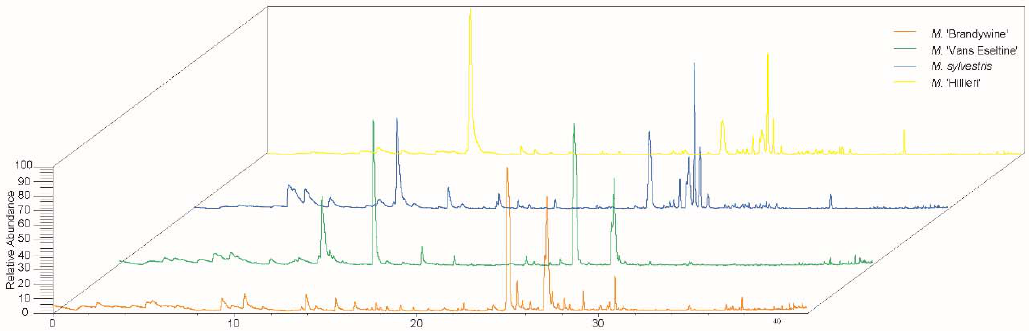
Figure 2. Total ionic chromatogram of the volatile compounds emitted from the flowers of the four Malus taxa.